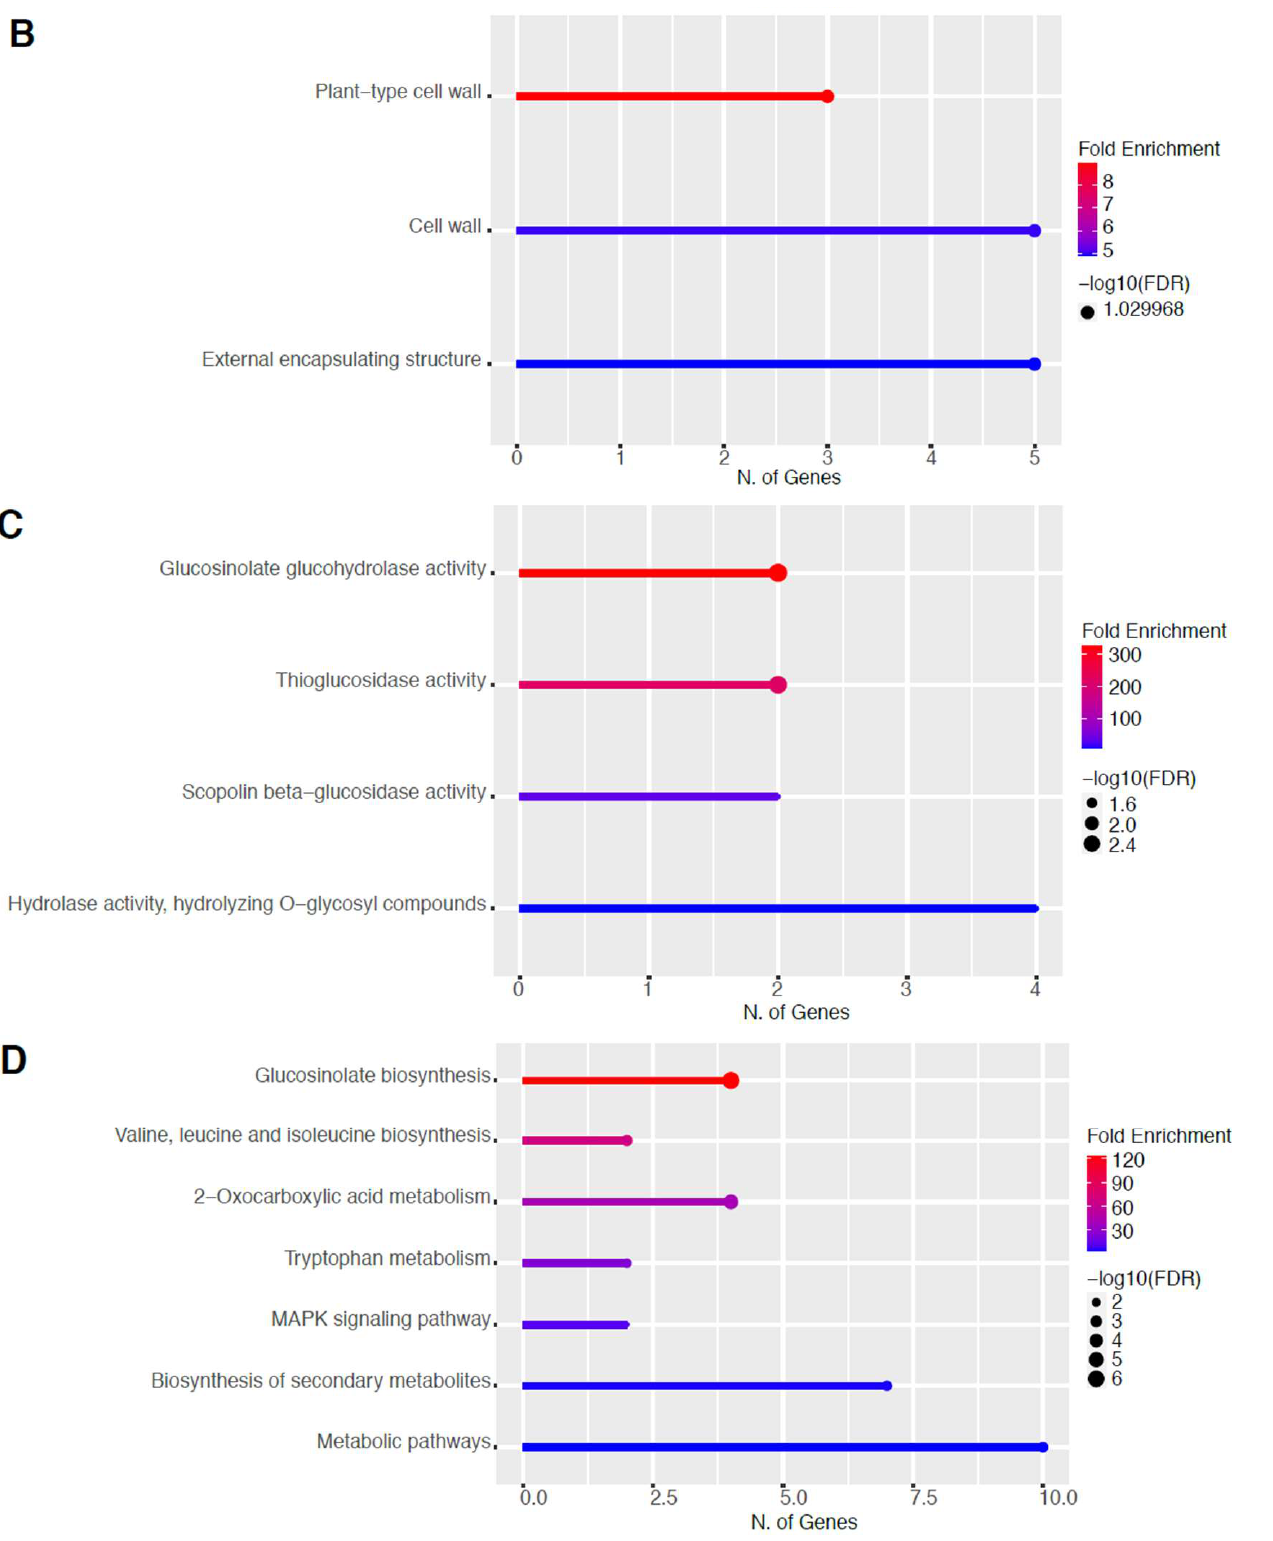
Figure 7. Gene enrichment analysis for upregulated genes after 80 s plasma treatment. Lollipop diagrams provide information about GO fold enrichment, significance (FDR in log10), and number of genes in each pathway. From top to bottom, GO categories are in the following order: ( A ) biological process, ( B ) cellular component, ( C ) molecular function, and ( D ) KEGG